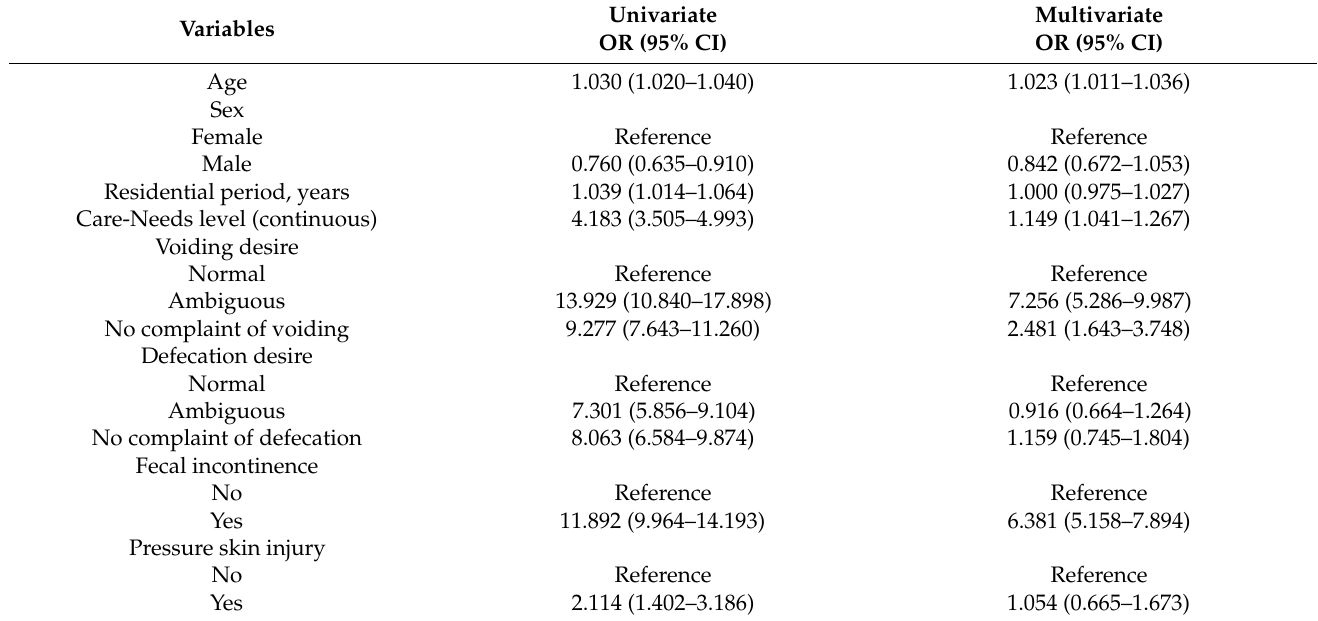
Table 2. Risk factors of urinary incontinence.